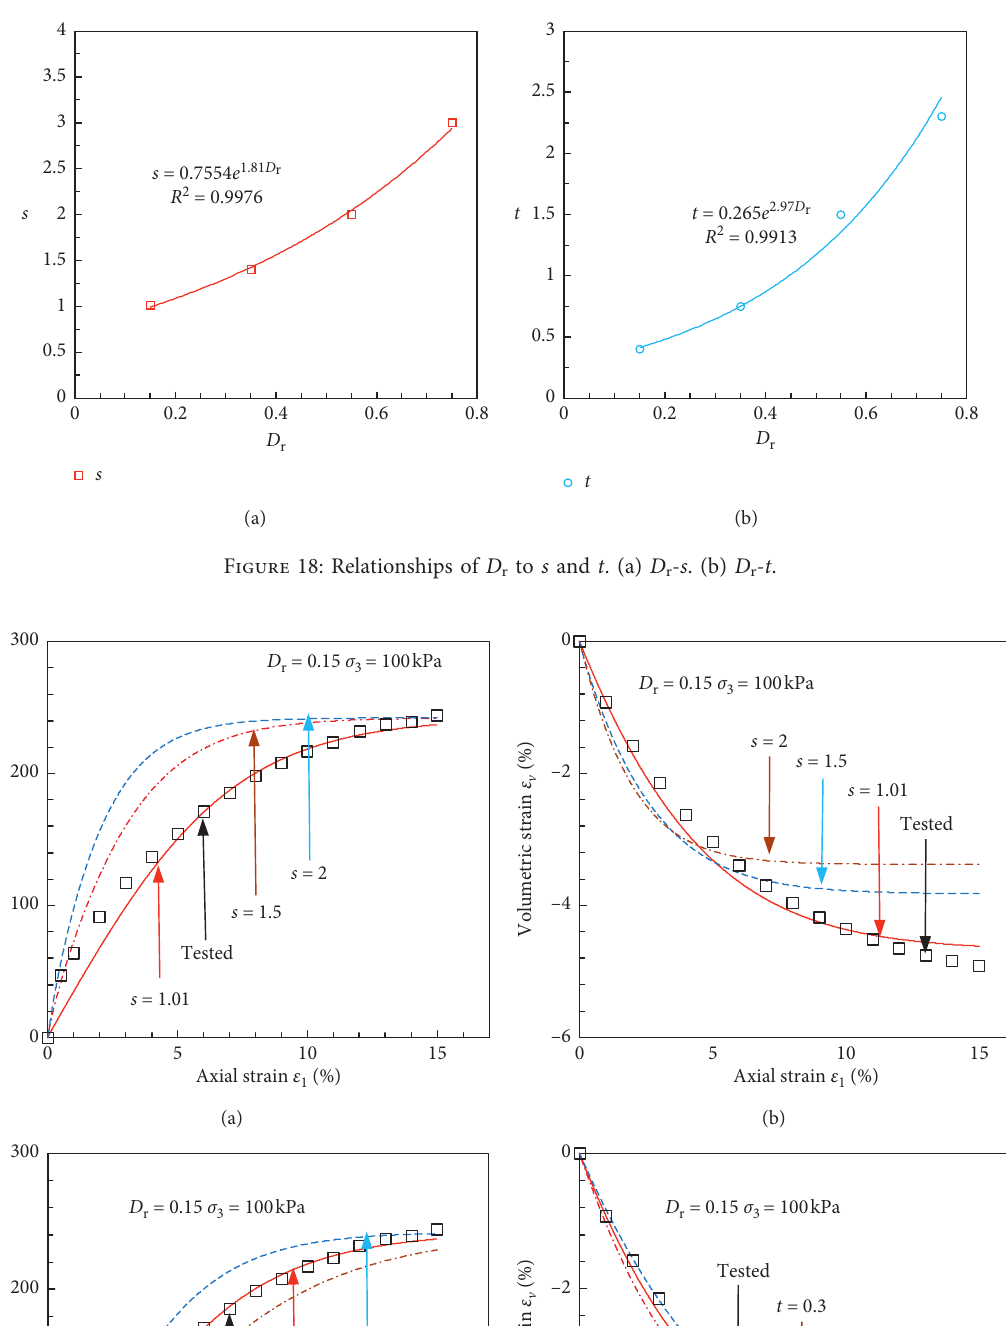
Figure 19: Effects of s and t on the stress-strain curves and volumetric strain-axial strain curves. (a) s -stress-strain curves. (b) s -volumetric strain-axial strain curves. (c) t -stress-strain curves. (d) t -volumetric strain-axial strain